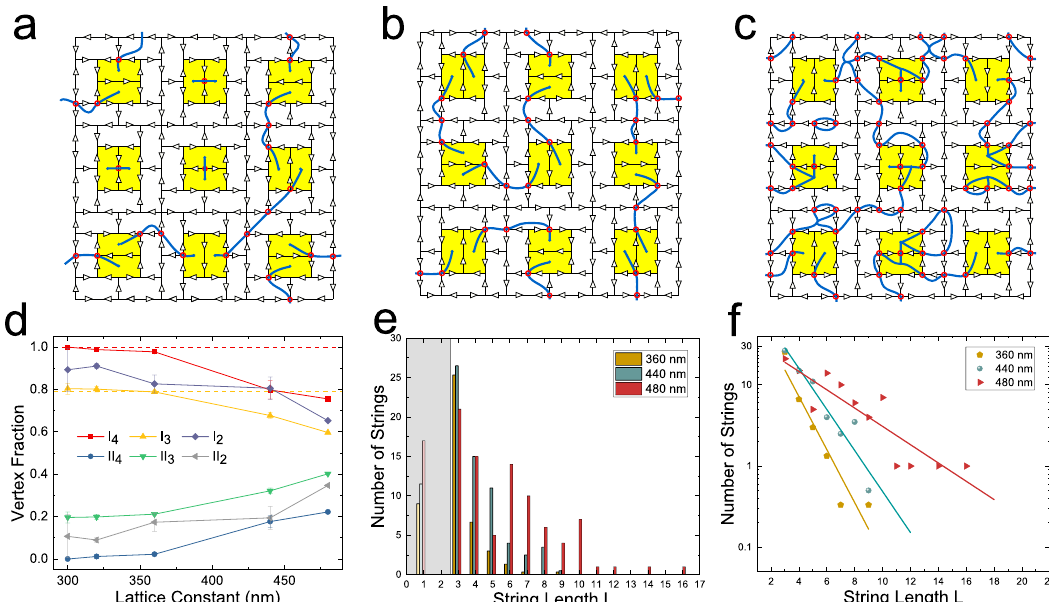
Fig. 3 Thermal annealing experimental results. a – c Examples of moment con fi gurations for small portions of the arrays measured after annealing, with both the moments and strings represented for samples with lattice constants of 360 nm, 320 nm, and 480 nm, respectively. Additional raw MFM data are given in Supplementary Note 3. d The vertex fractions observed after annealing as a function of lattice constant (error bars represent standard deviations of the data). With decreasing lattice constant, i.e., increasing interactions, the fractions converge to those expected for the disordered string ground state. Dashed lines are the expected vertex fraction of I 4 and I 3 for the disordered string ground state. e The distribution of string lengths for different lattice constants where the grey section covers those strings that are connecting only contiguous interior plaquettes and therefore are expected to have a different energy scale. We estimate the uncertainty in these values to be approximately 10 – 15%, based on the number of strings in the images. f The data from ( e ) plotted on a semi-logarithmic scale with exponential fi ts as described in the